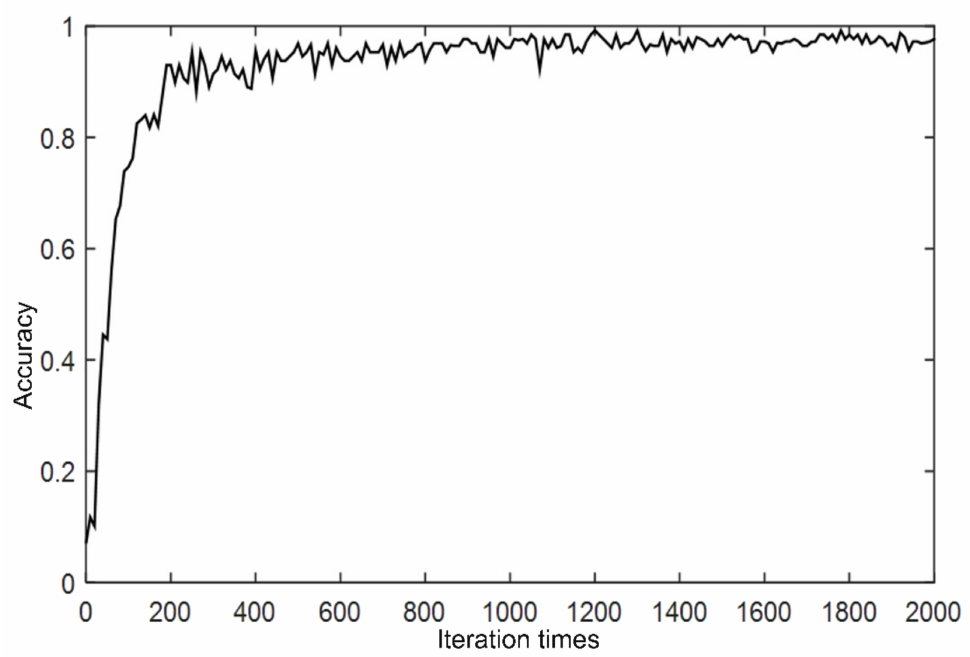
Figure 6. Prediction accuracy diagram of haze classification by 1D-convolutional neural network.